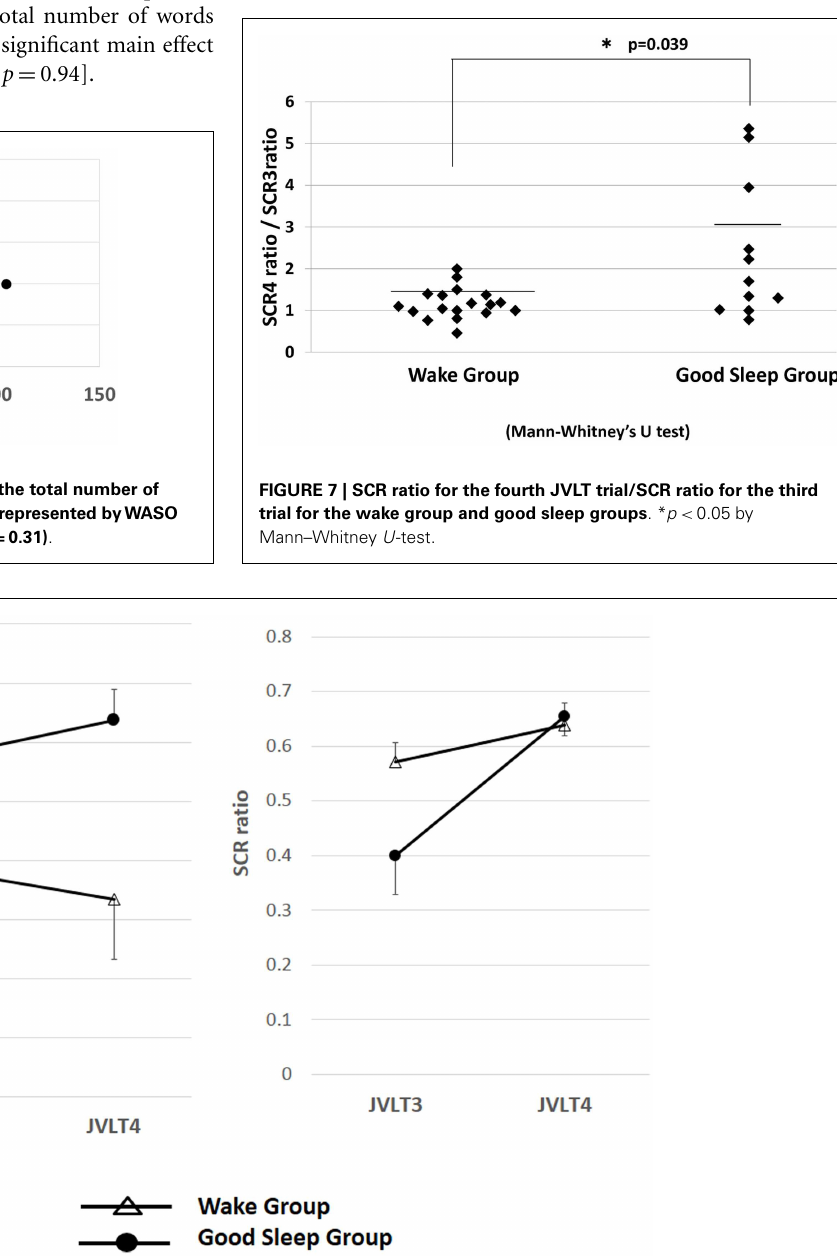
and a significant main effect ofTime was not observed [ F (1, 27) = 0.06, p = 0.94].The error bars represent standard error of the mean. Repeated measures ANOVA was conducted to see the effect of sleep on the SCR ratio with Group [sleepers showingWASO ≤ 60min ( n = 11) vs. awake subjects] as between subject variable, and time as within-subject variable. A significant Group × Time interaction was observed in the SCR ratio [ F (1, 27) = 6.23, p =